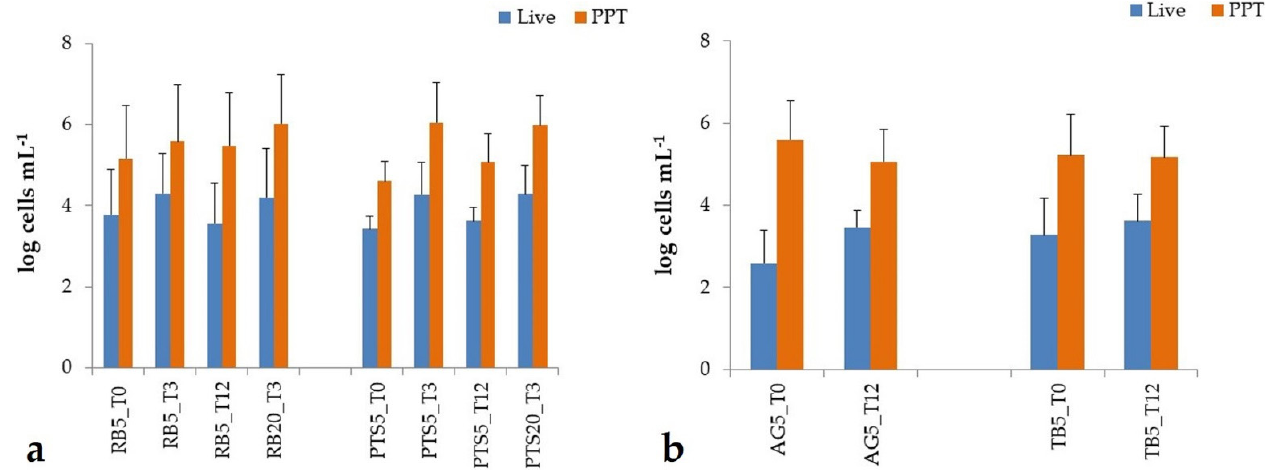
Figure 8. Mean values + standard deviations of total prokaryotic (PPT) and living (Live) cells abundance in seawater samples collected at 5 and 20 m at the start of the experiment (Time 0, November 2017), in January 2018 (Time 3, short-term experiment) and at the end (Time 12, November 2018) of the long-term experiment. ( a ), Road Bay area; ( b ) Tethys Bay area. RB, Road Bay (impact station, on the left); PTS, Punta Stocchino (control station, on the right); AG, Amorphous Glacier (impact station, on the left). TB, Tethys Bay (control station, on the right); PVC: Polyvinyl chloride; PE: Polyethylene.